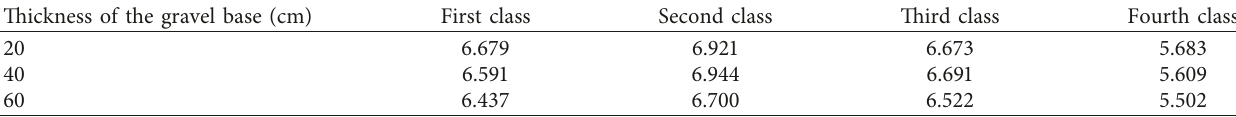
Table 2: Vertical deformation for the asphalt pavement thickness of 10cm.